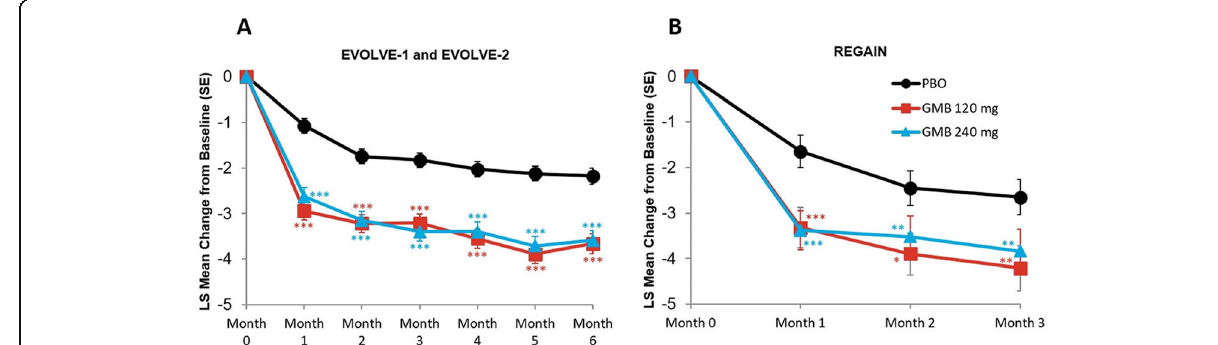
Fig. 2 Monthly mean change in monthly migraine headache days with photophobia and phonophobia. * p ≤ 0.05 vs PBO; ** p ≤ 0.01 vs PBO; *** p ≤ 0.001 vs PBO. GMB, galcanezumab; LS,least squares; PBO, placebo; SE, standard